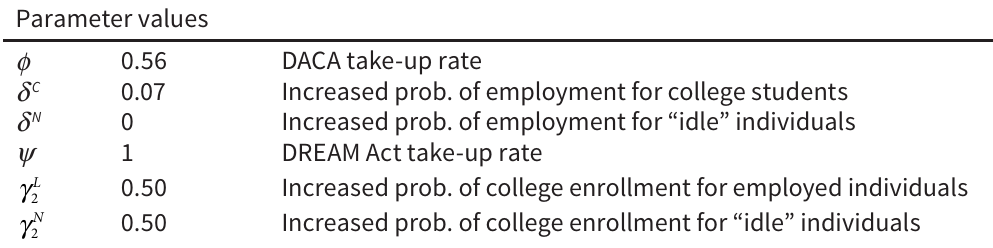
Additional Parameters